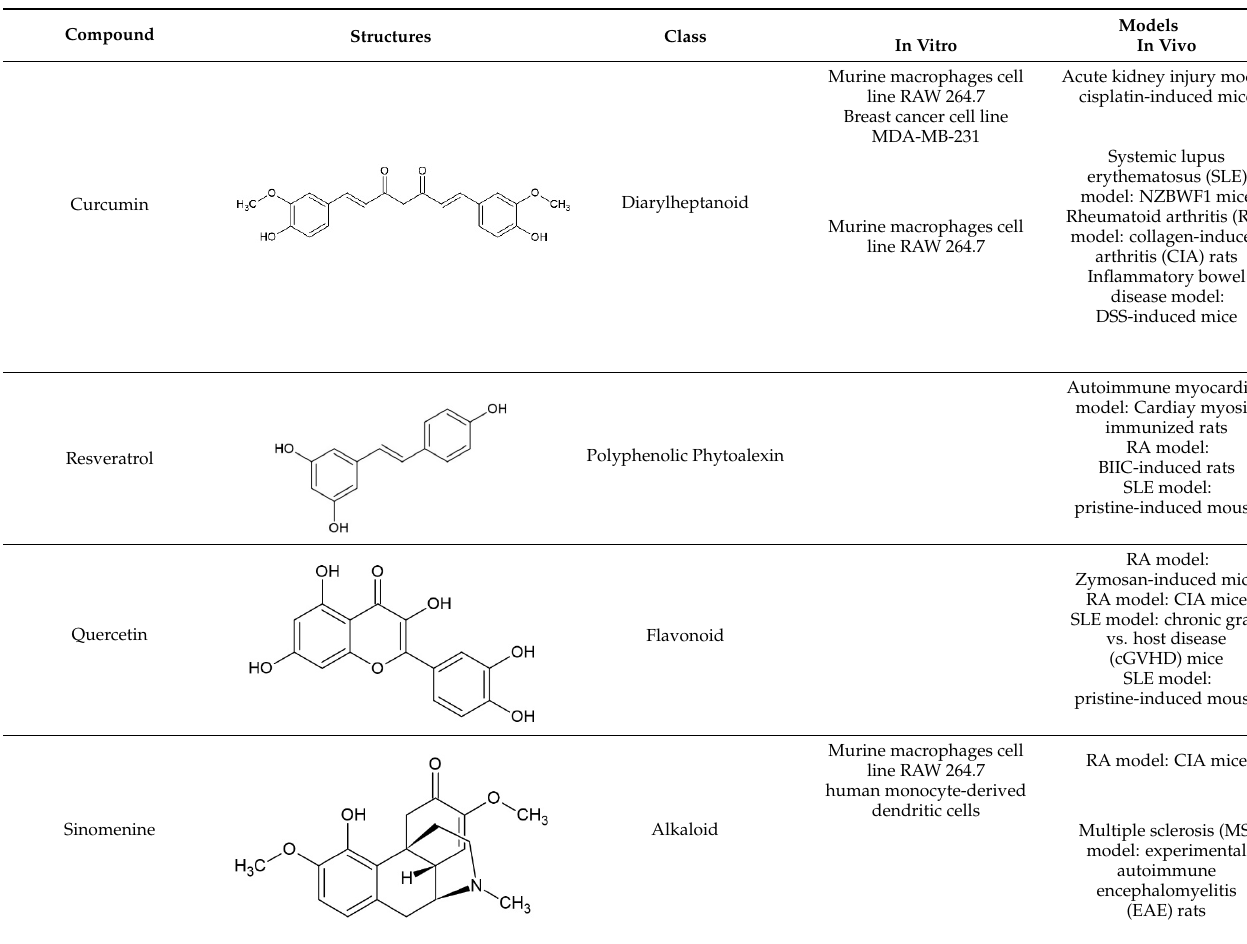
Multiple sclerosis (MS) model: